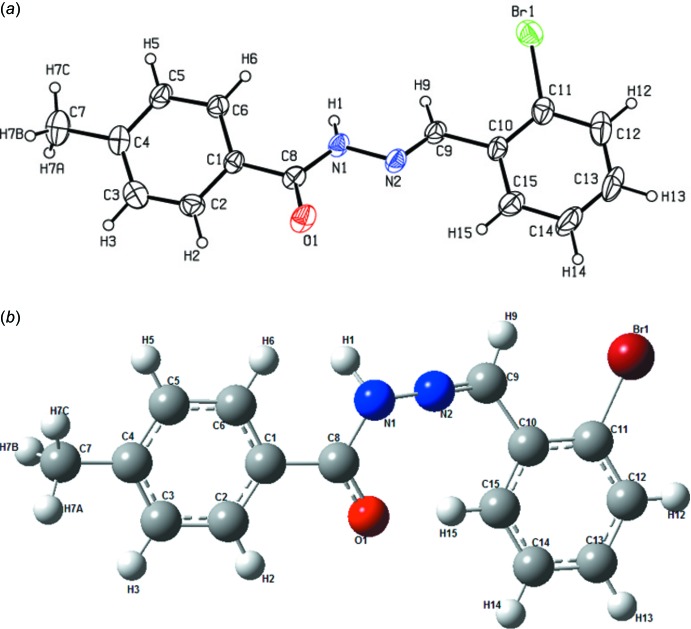
(a) The mol­ecular structure of the title compound, with displacement ellipsoids drawn at the 50% probability level. (b) The optimized structure of the title compound.